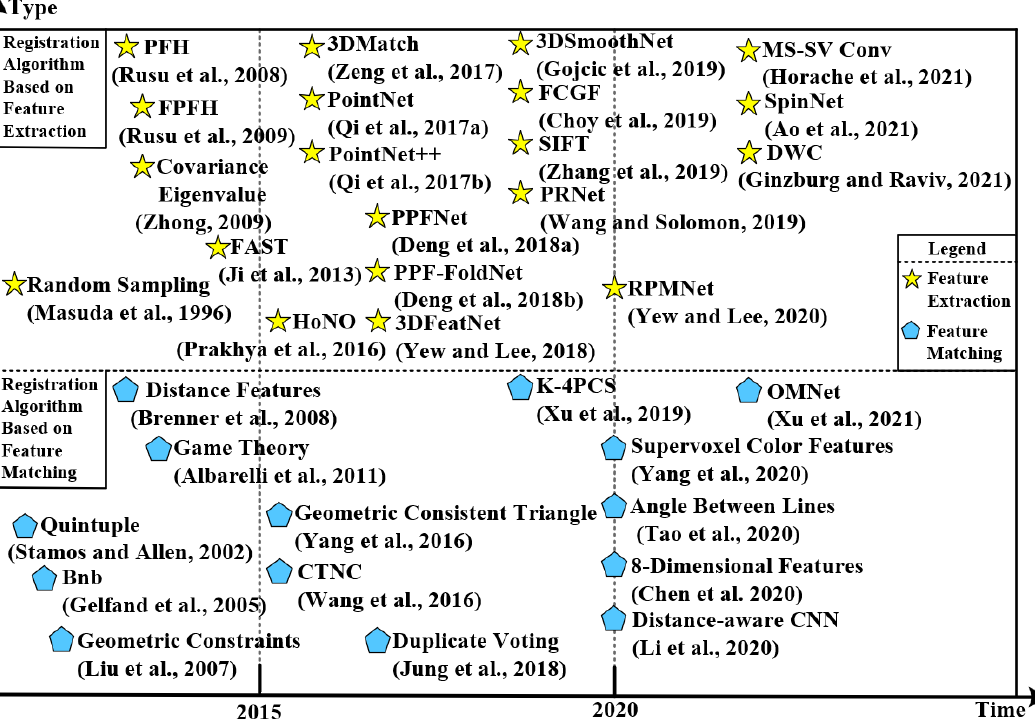
Figure 9. Chronological overview of registration algorithms based on features [103 – 134].